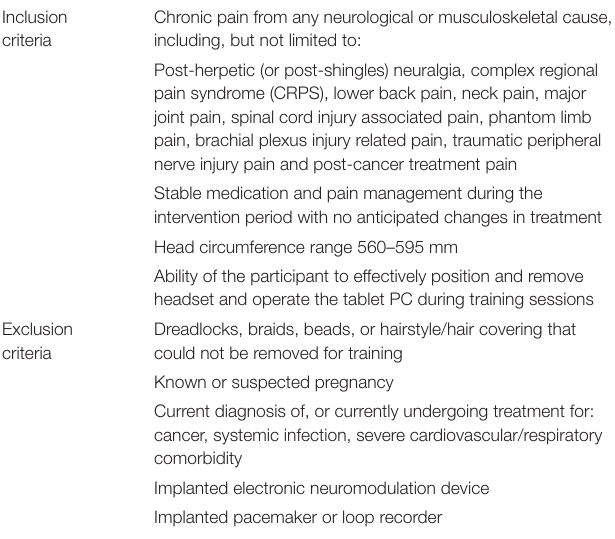
TABLE 1 | Axon brain train trial inclusion and exclusion criteria. Inclusion criteria